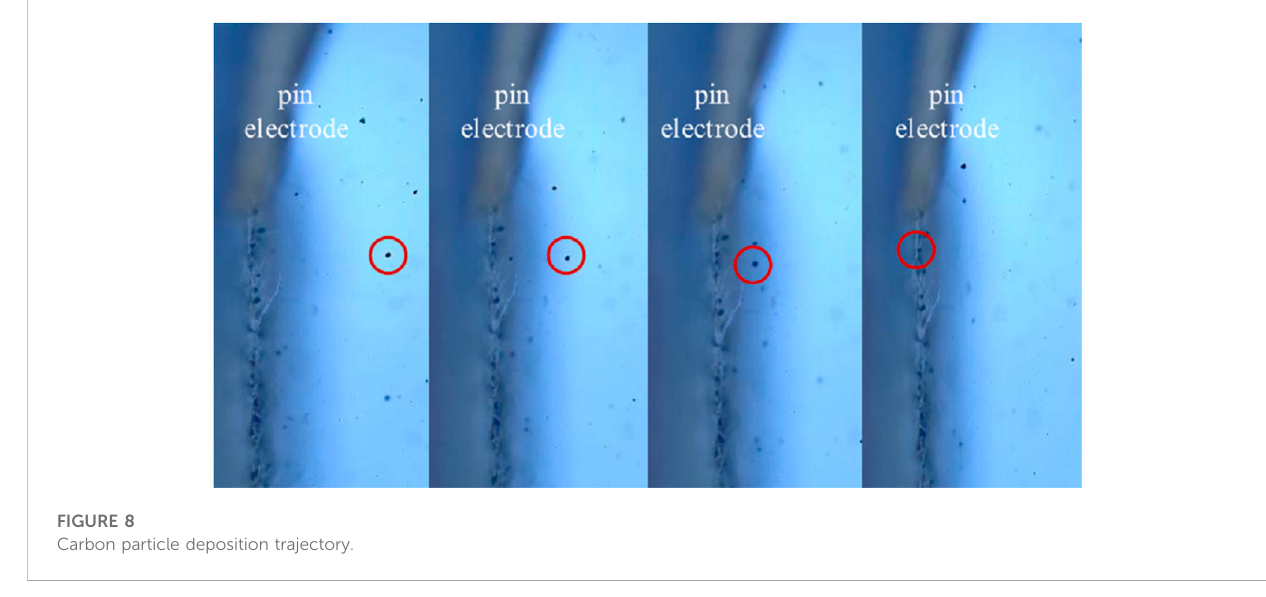
FIGURE 8 Carbon particle deposition